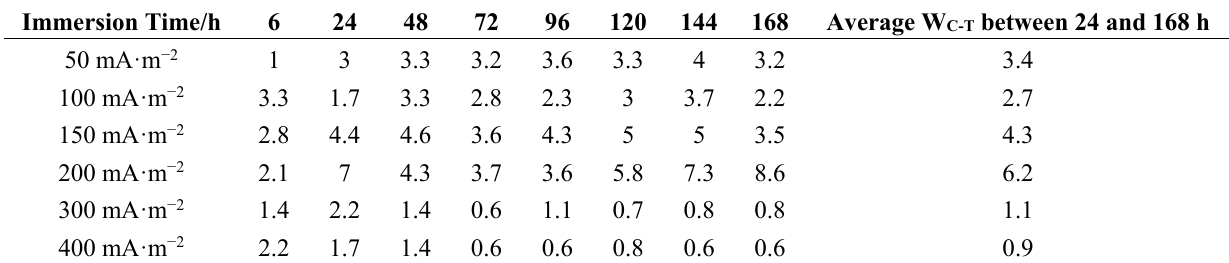
Table 5. Values of anodic charge transfer resistance R a / Ω ·cm 2 with immersion time at different applied current densities.